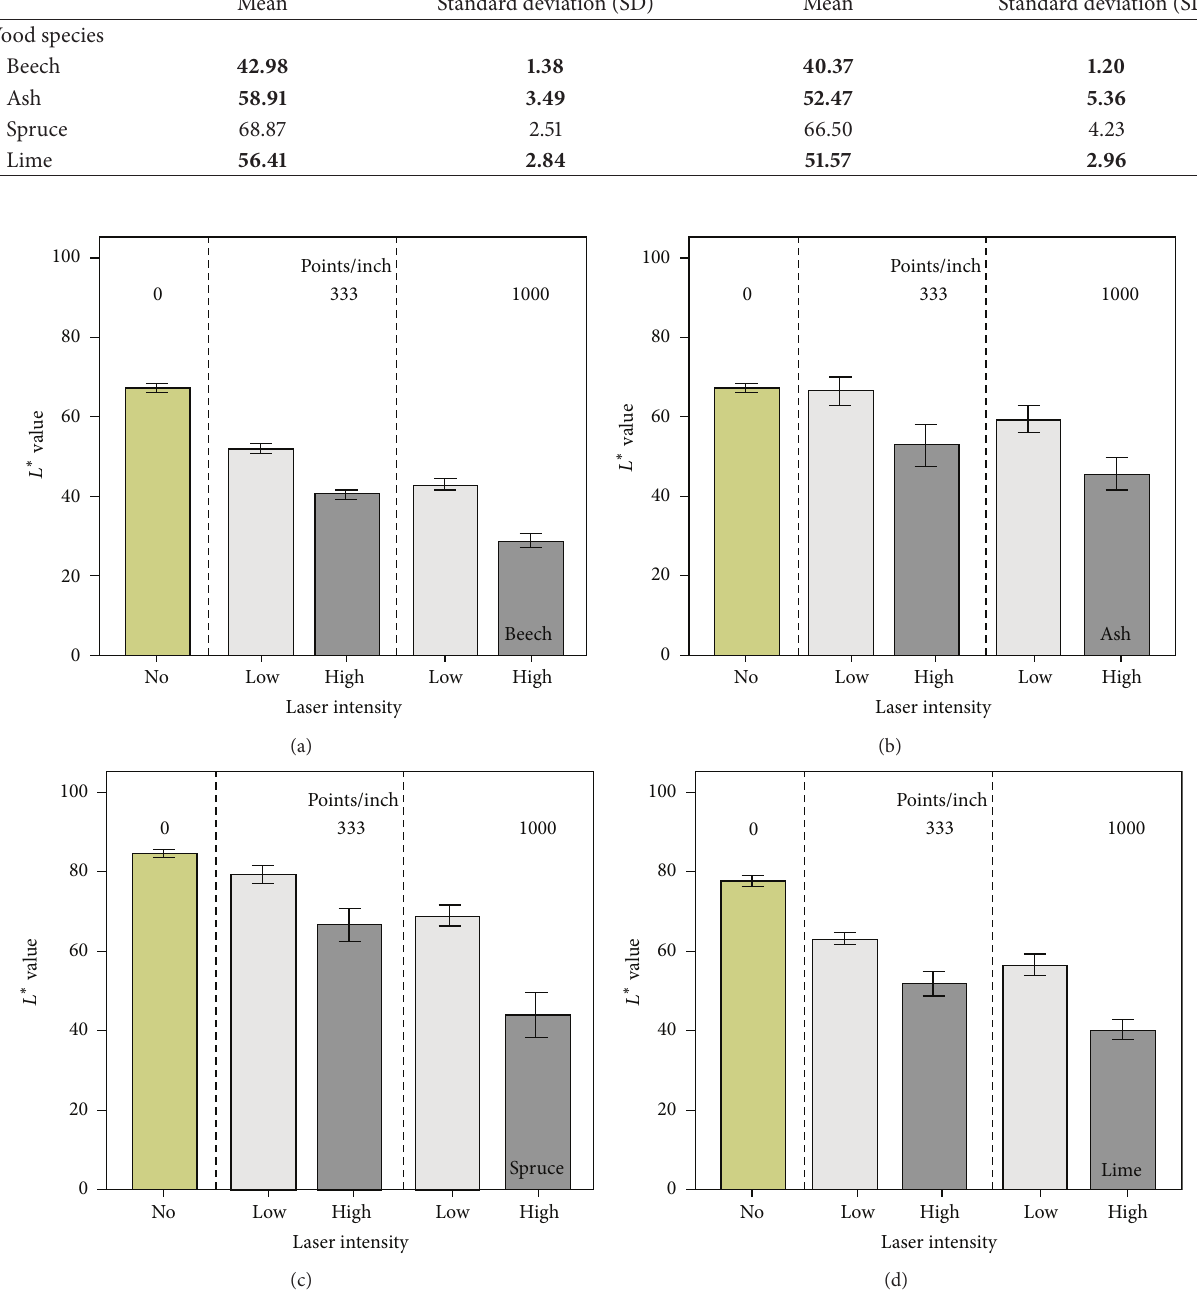
Table 1: Comparison of 𝐿 ∗ values of two laser treatments (intensity low and 333 points per inch compared to intensity high and 1000 points per inch). Bold cells indicate significant differences with equal variance.